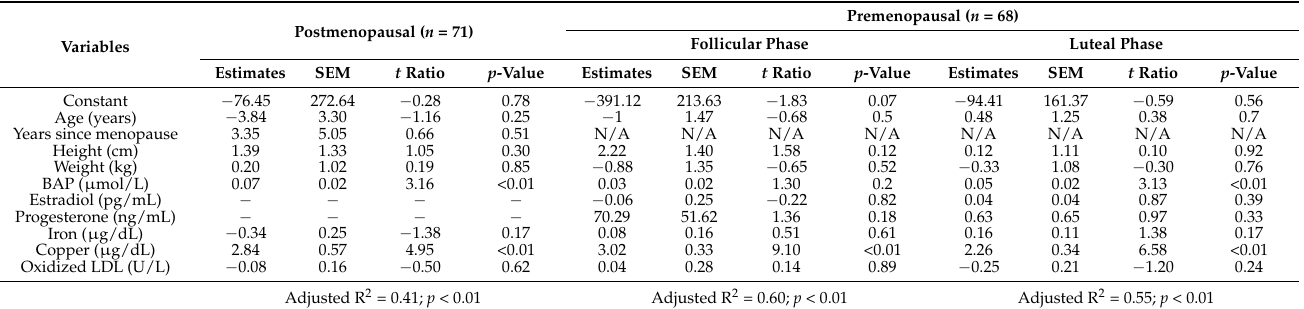
Table 2. Multiple regression models examining the influences of several variables on d-ROMs in postmenopausal and premenopausal women.